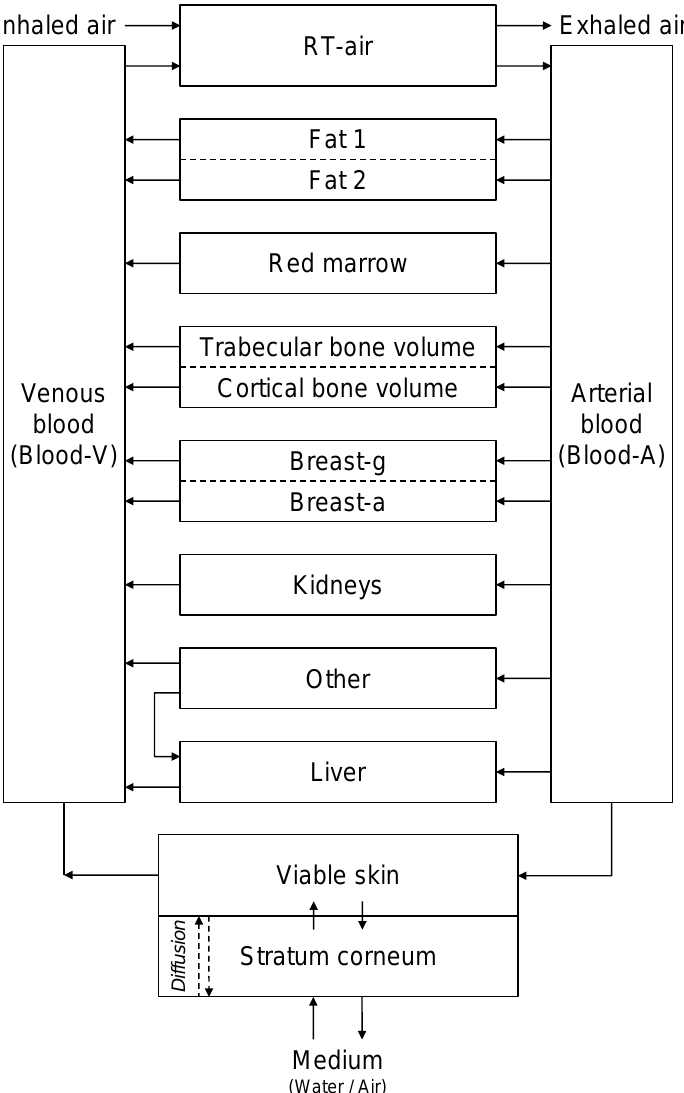
Figure 1. Schematic diagram of the biokinetic model for inhaled or skin absorbed radon. RT-air, respiratory air; Breast-g, glandular tissue of breast; Breast-a, adipose tissue of breast. The fundamental mathematical description is explained in [4]. The movement of radon in the compartment “Stratum corneum ” is expressed by the diffusion equation (see the text).